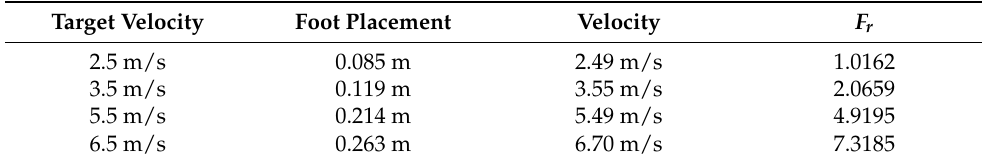
Table 5. Simulation results for running in various target velocity